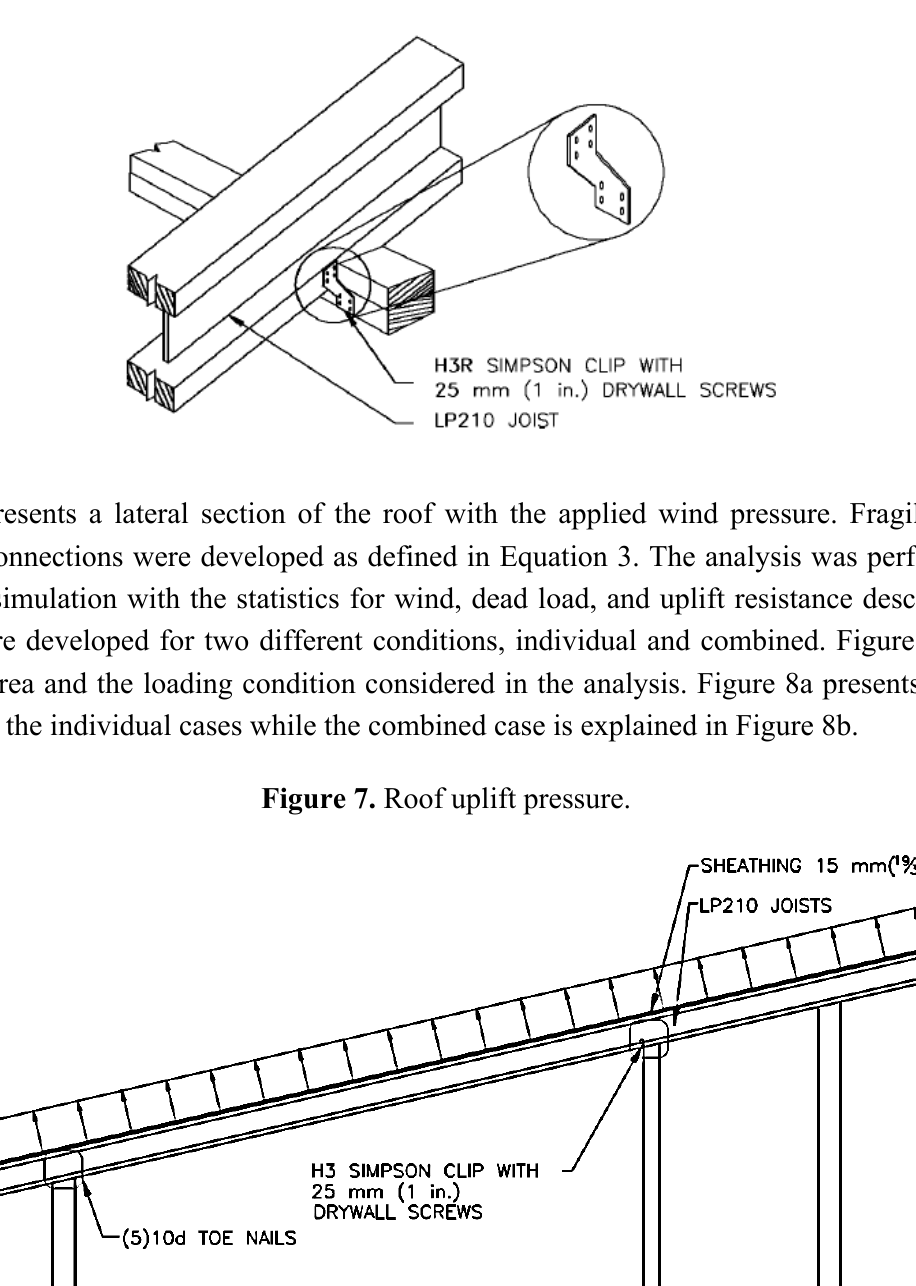
Figure 6. Joist connection to the top plates.